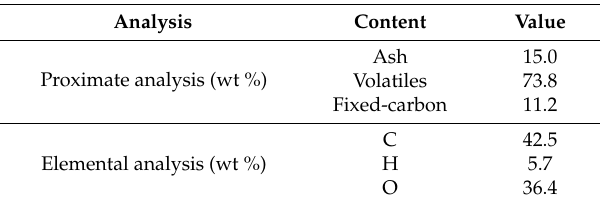
Table 1. Composition of rice